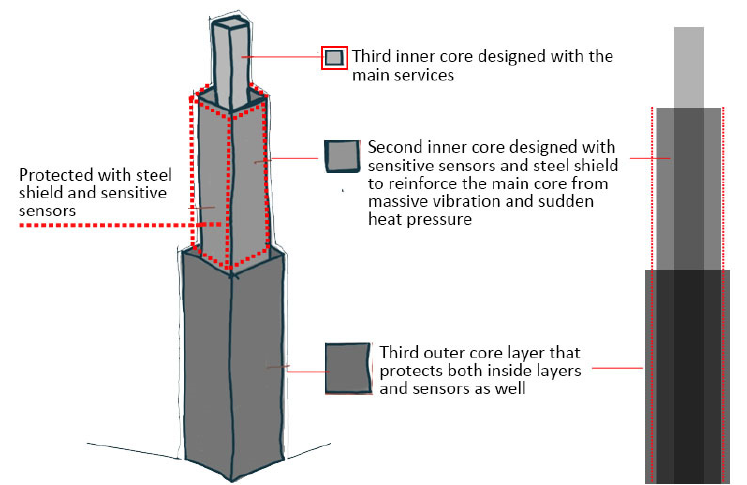
Figure 7. Diagram illustrating the proposed building’s three-supported core system for designing in warzone areas. Source: (Y.M.).